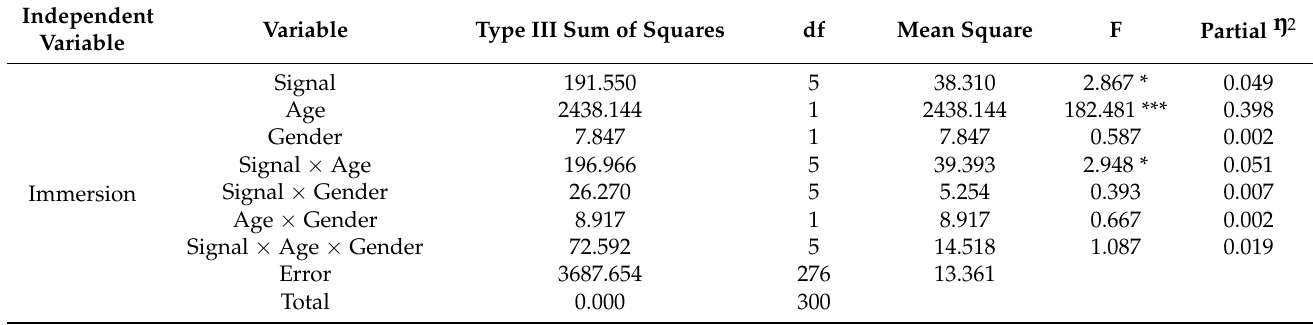
Table 3. The results of three-way analysis of variance (ANOVA) among signal, age and gender in arousal. Table 5. The results of three-way ANOVA among type of fire alarm, age and gender for immersion.